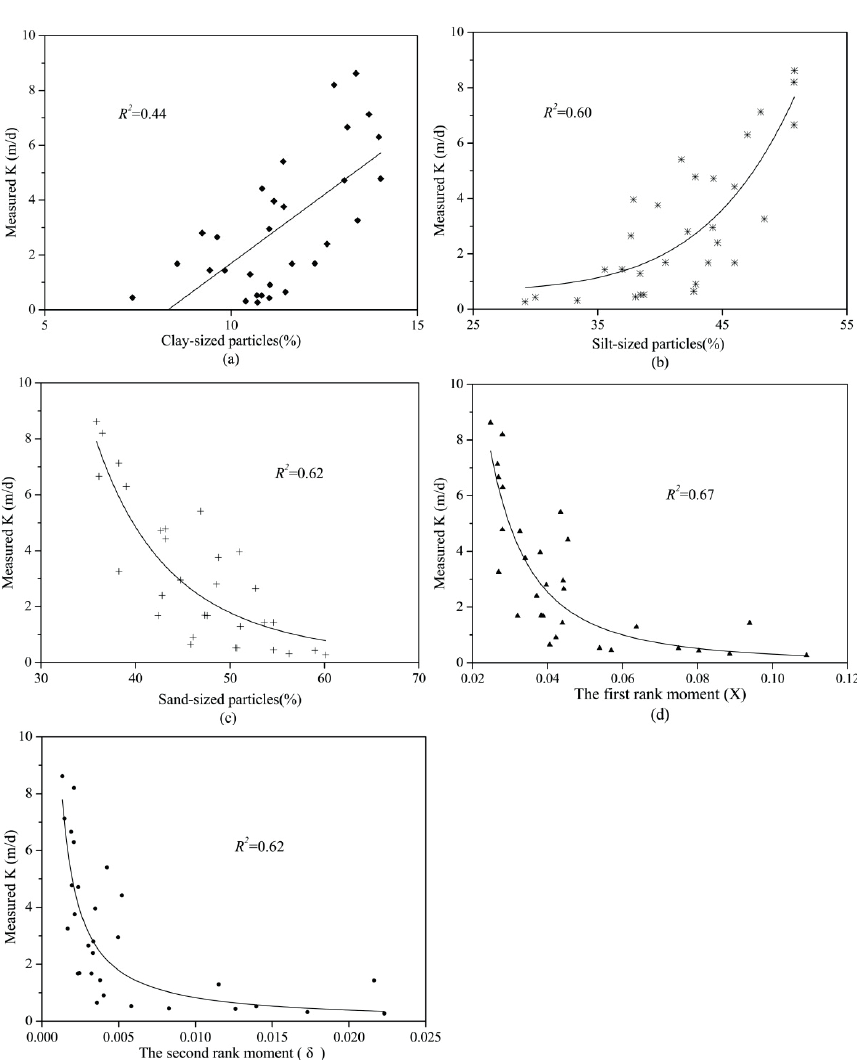
Fig. 2 Plots of the relationship between hydraulic conductivity and the five predictor variables of grain- size distribution.